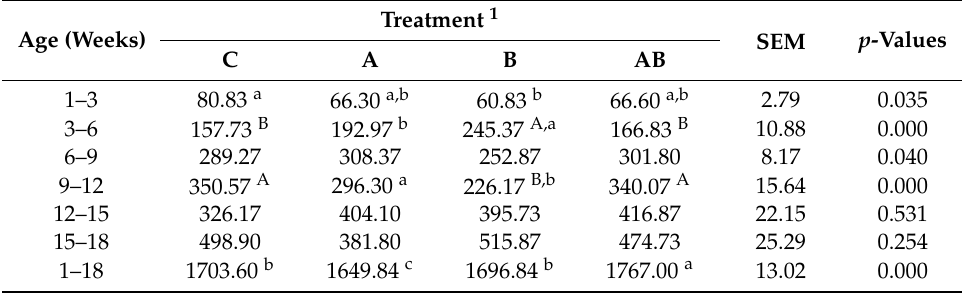
Table 2. E ff ect of the treatment on body weight gain (g) of Kuroiler chickens reared under tropical climatic